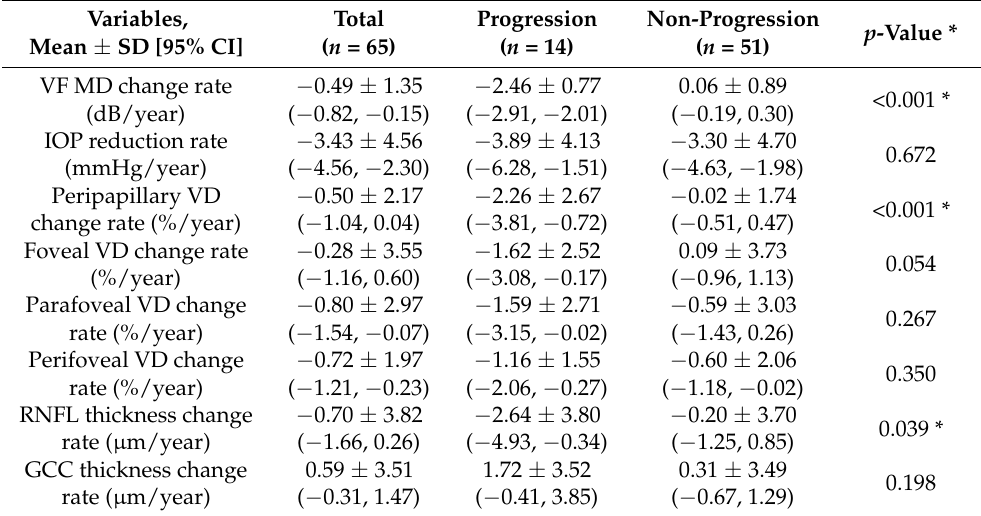
Table 2. Comparison of the postoperative change rate of the parameters between the VF progression and non-progression group.